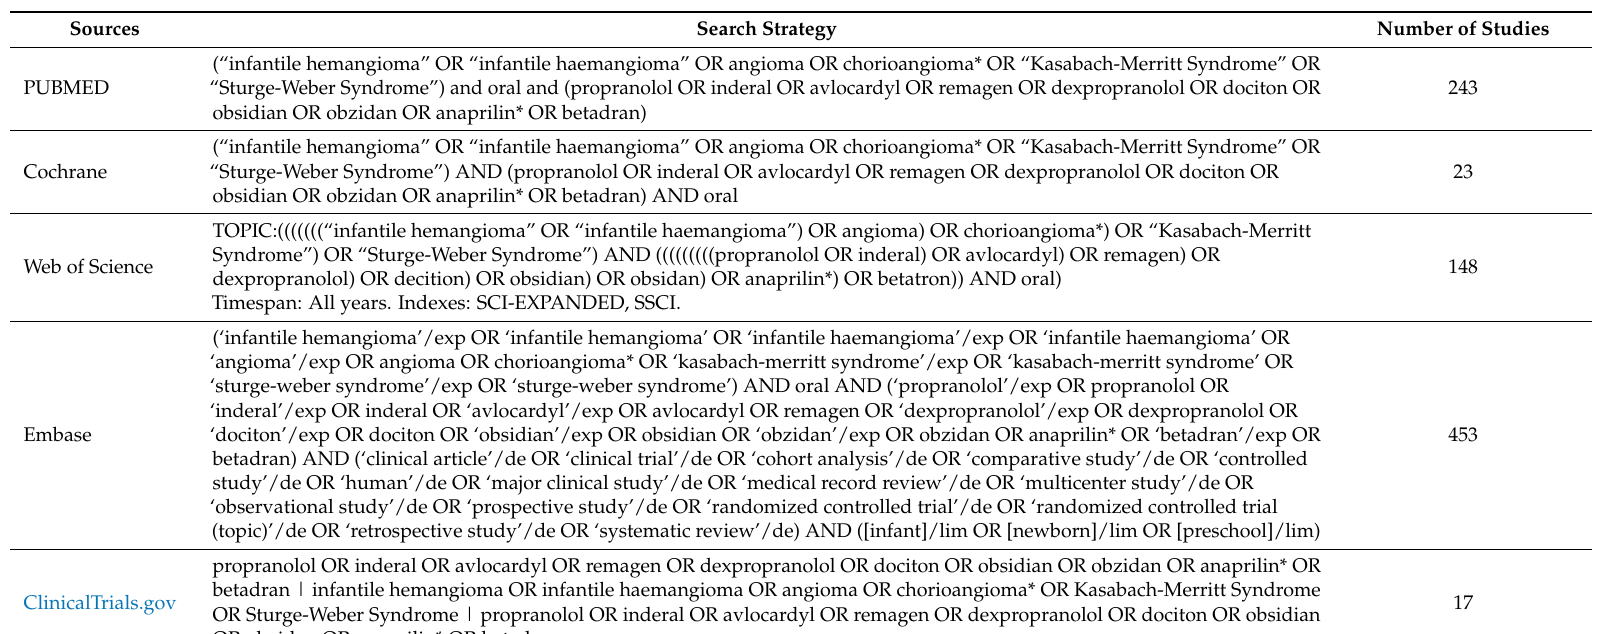
Table A1. Search terms used for each